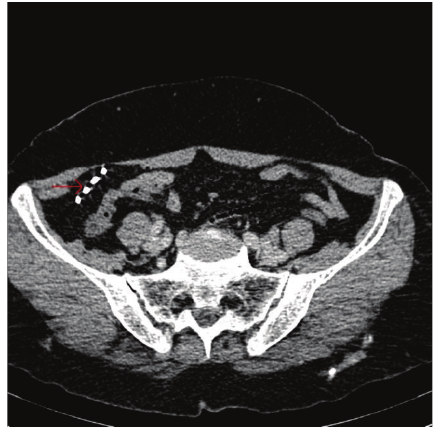
Figure 2: CT scan shows the intrauterine device in the right upper front part of the